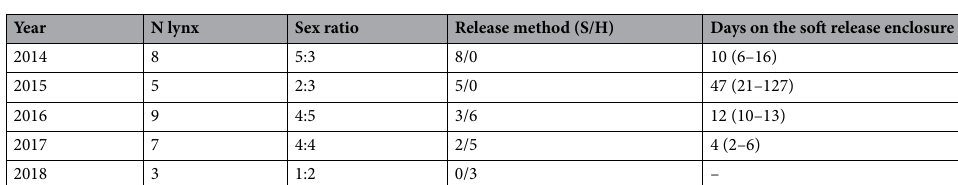
Table 1. Reintroduced individuals in the Matachel Valley each year of the study period. Sex ratio M:F. Release method S soft, H hard. Days spent in the soft release enclosure (mean and